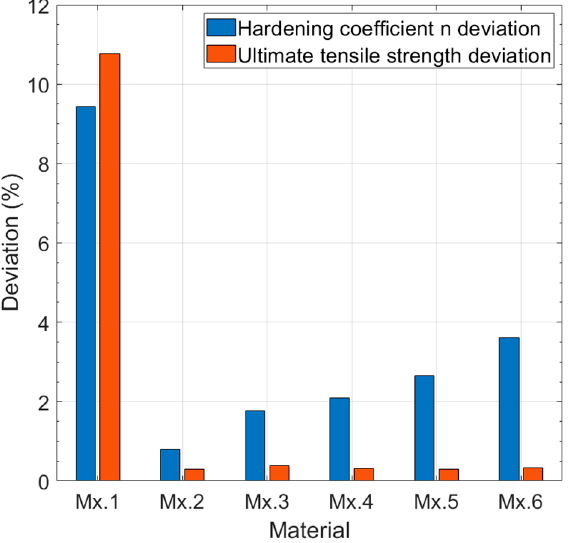
Figure 12. Comparison of the deviations of n calc and σ u_calc.